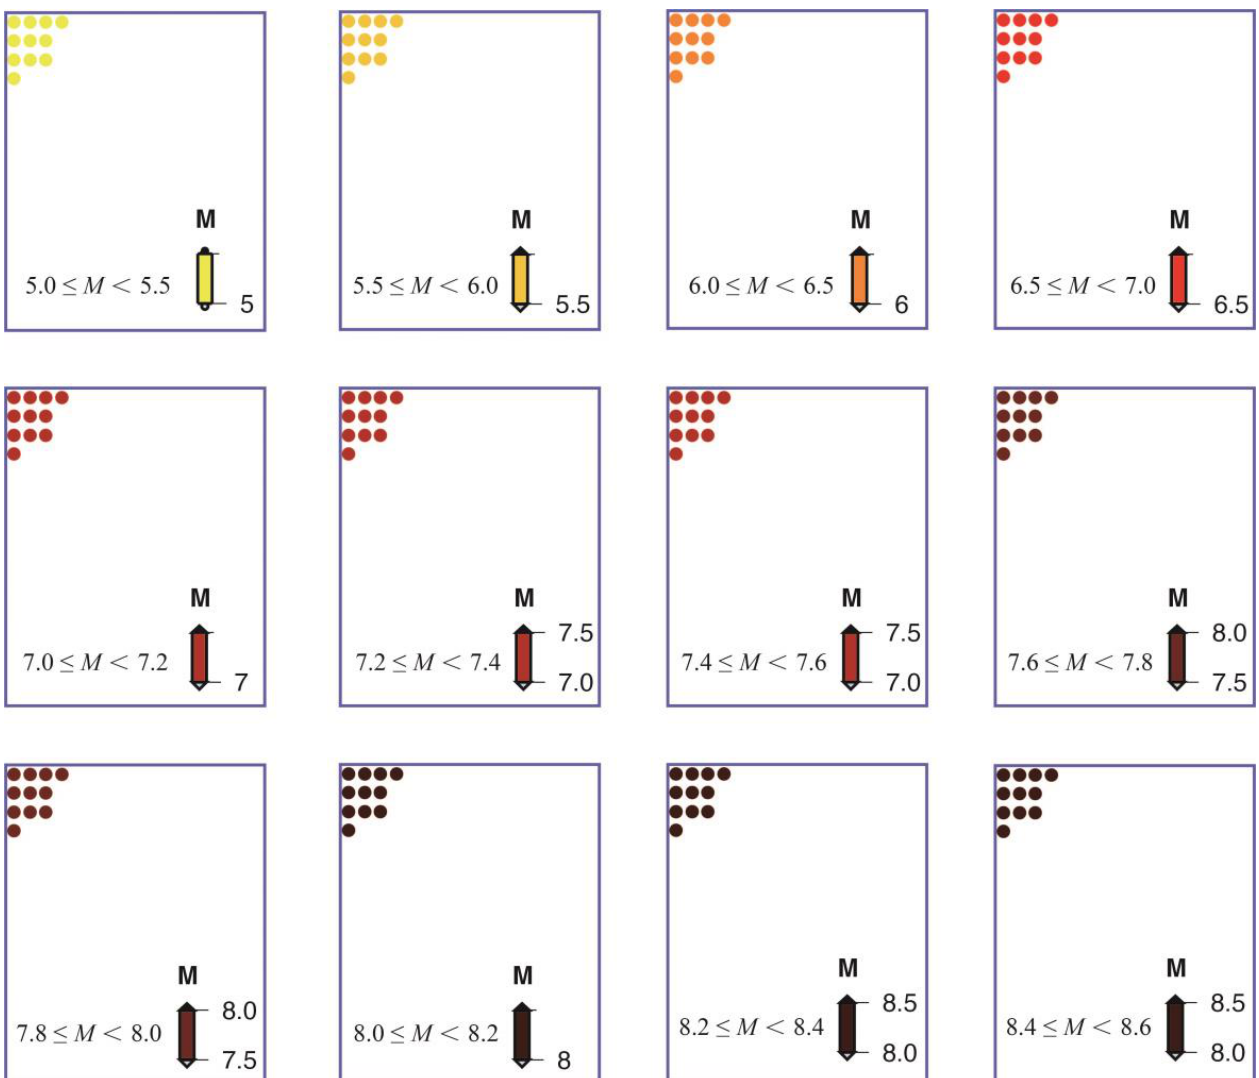
Figure 9. The sources to be used in the 12 scenario computations, with a different value of magnitude for each cellular earthquake source. For each scenario computation, the value of magnitude is defined as the lower limit of the corresponding magnitude, e.g., the adopted magnitude for computing MMI map is 5.0 for the 5.0 ≤ M < 5.5